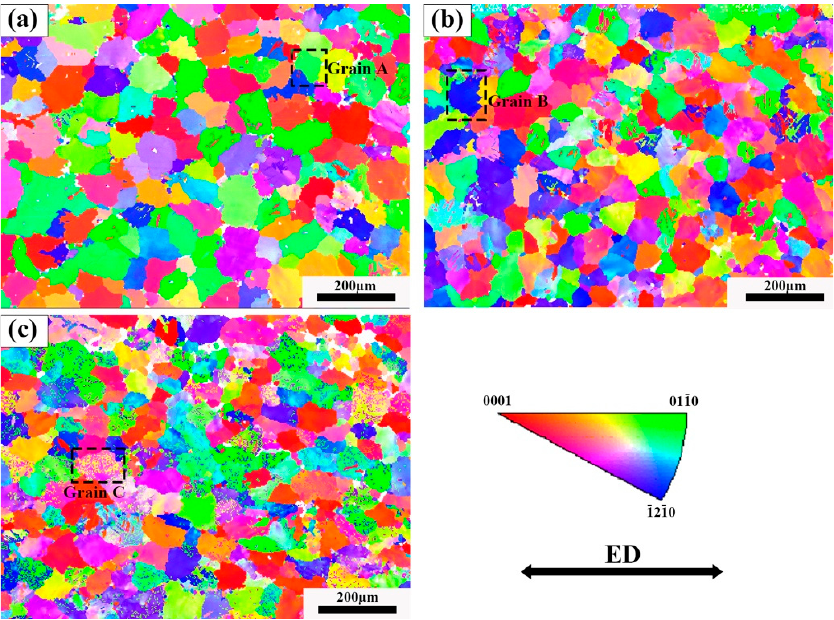
Figure 11. IPF diagram near the fracture after stretching, ( a ) Alloy A, ( b ) Alloy B, ( c ) Alloy C.